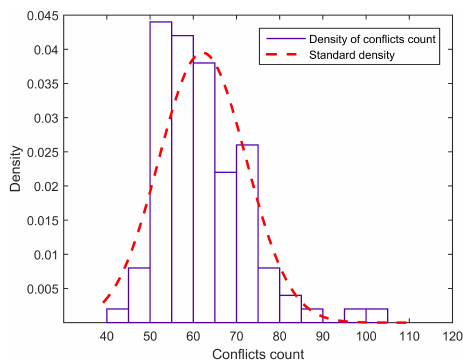
Figure 5. The example of the probability density of the number of conflicts for 35 spacecrafts and 5 control